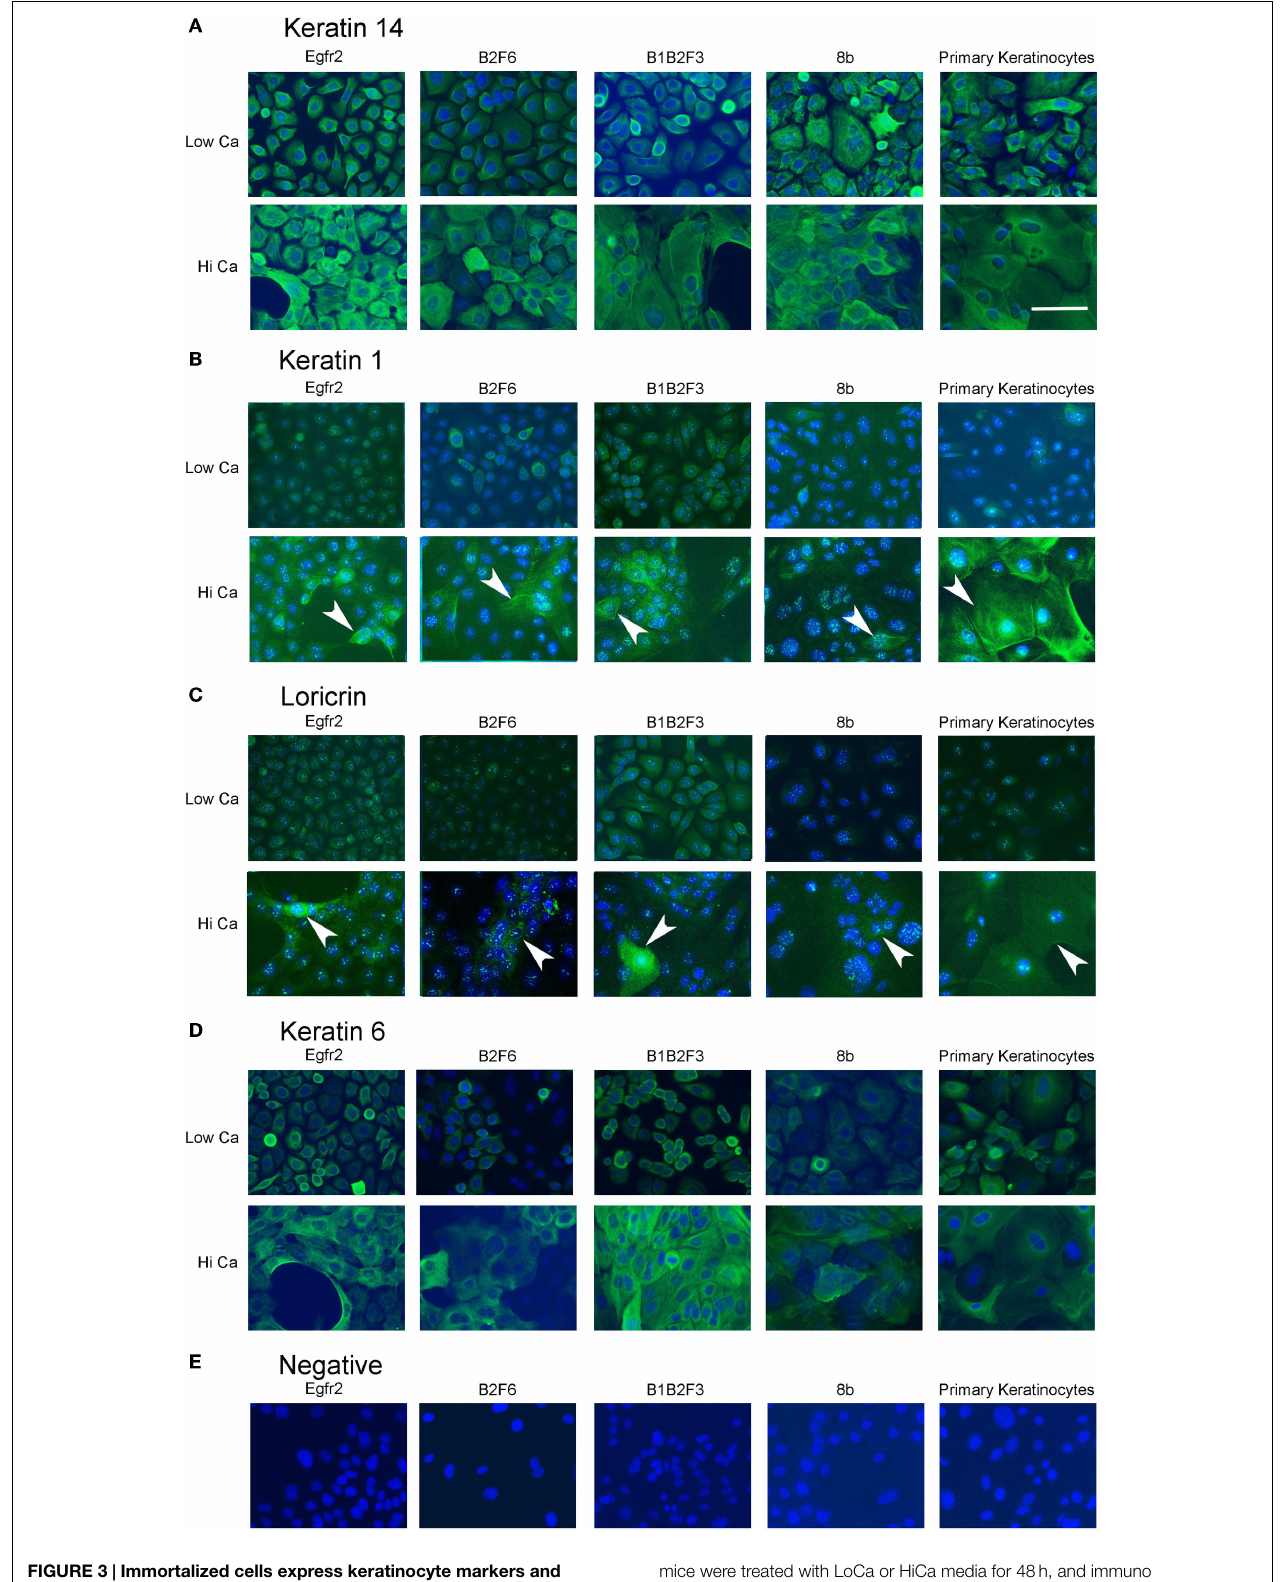
FIGURE 3 | Immortalized cells express keratinocyte markers and differentiate in response to increased calcium . Immortalized EGFR2 cells (P 42), immortalized B2F6 cells (P42), immortalized B1B2F3 cells (P29), immortalized 8b cells (P53), or primary keratinocytes from FVB/N